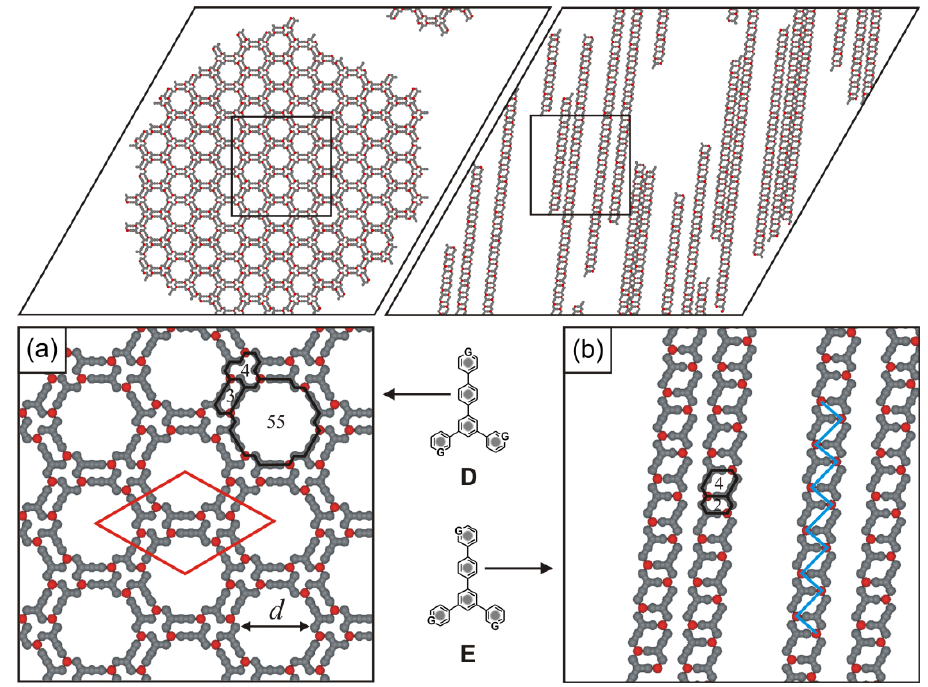
Figure 4. ( a ) Highly crystalline metal–organic phase composed of 600 metal atoms and 600 ligands D in a 1:1 stoichiometric ratio; ( b ) adsorbed overlayer comprising 600 metal atoms and 600 ligands E in a 1:1 stoichiometric ratio. In a magnified fragment of the open porous network, a rhombic unit cell is marked (solid red line). The solid black lines mark the edges of empty nanopores differing in size and shape. Inside the highlighted nanopores, the numbers of empty adsorption sites are given. The solid blue line denotes the zig-zag pattern created by metal atoms cementing the metal–organic ladder.